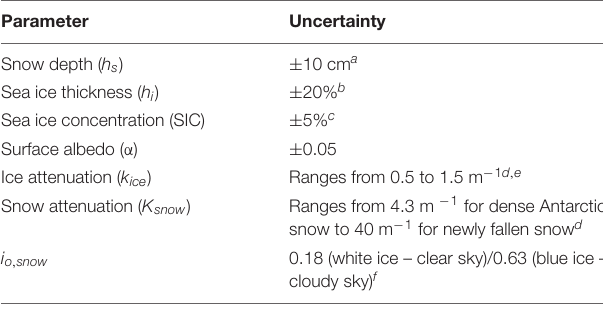
TABLE 2 | Uncertainties used for sensitivity analysis of under-ice PAR to uncertainties in sea ice/snow physical properties and attenuation properties used in the Beer–Lambert